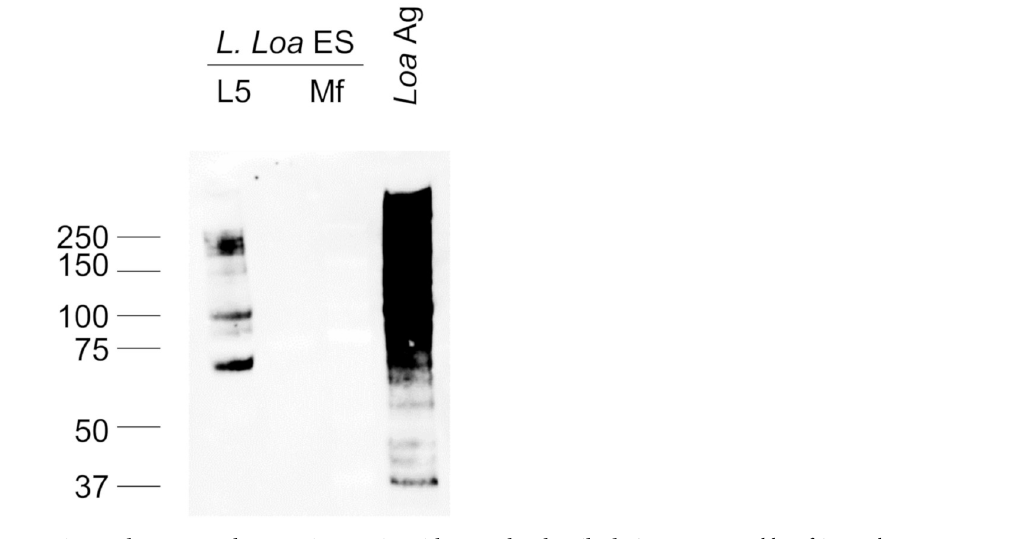
Fig 4. L . loa secretes glycoproteins reactive with monoclonal antibody AD12. Western blot of AD12 glycoproteins immunoaffinity purified from 1mL of culture supernatant (ES products) from L . loa adult worms (L5) or microfilaria